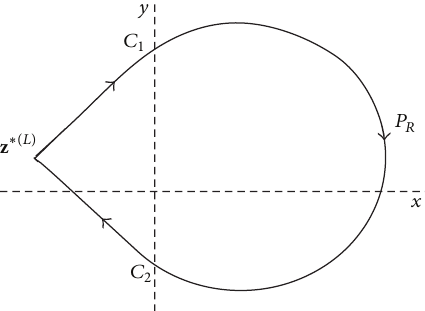
Figure 4: A nondegenerate homoclinic